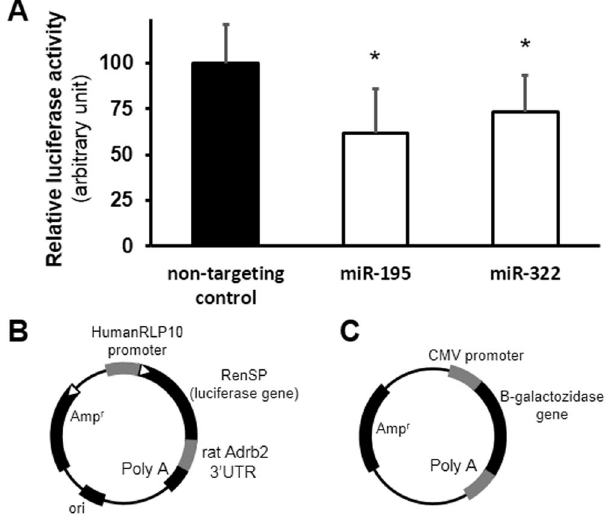
Figure 4. Luciferase assay validation for selected miRNAs and Adrb2 mRNA 3 ′ UTR interaction. Luciferase signal intensity was significantly downregulated by selected targeting miRNAs, also miR-106 and miR-322, compared to non-targeting control miRNA ( A ). * < 0.05 vs. non-targeting control, n = 3 (one-way ANOVA followed by Dunnett’s post hoc test) Representative maps of Lightswitch luciferase reporter vector ( B ) and beta- galactosidase reporter vector ( C ) used for miRNA luciferase